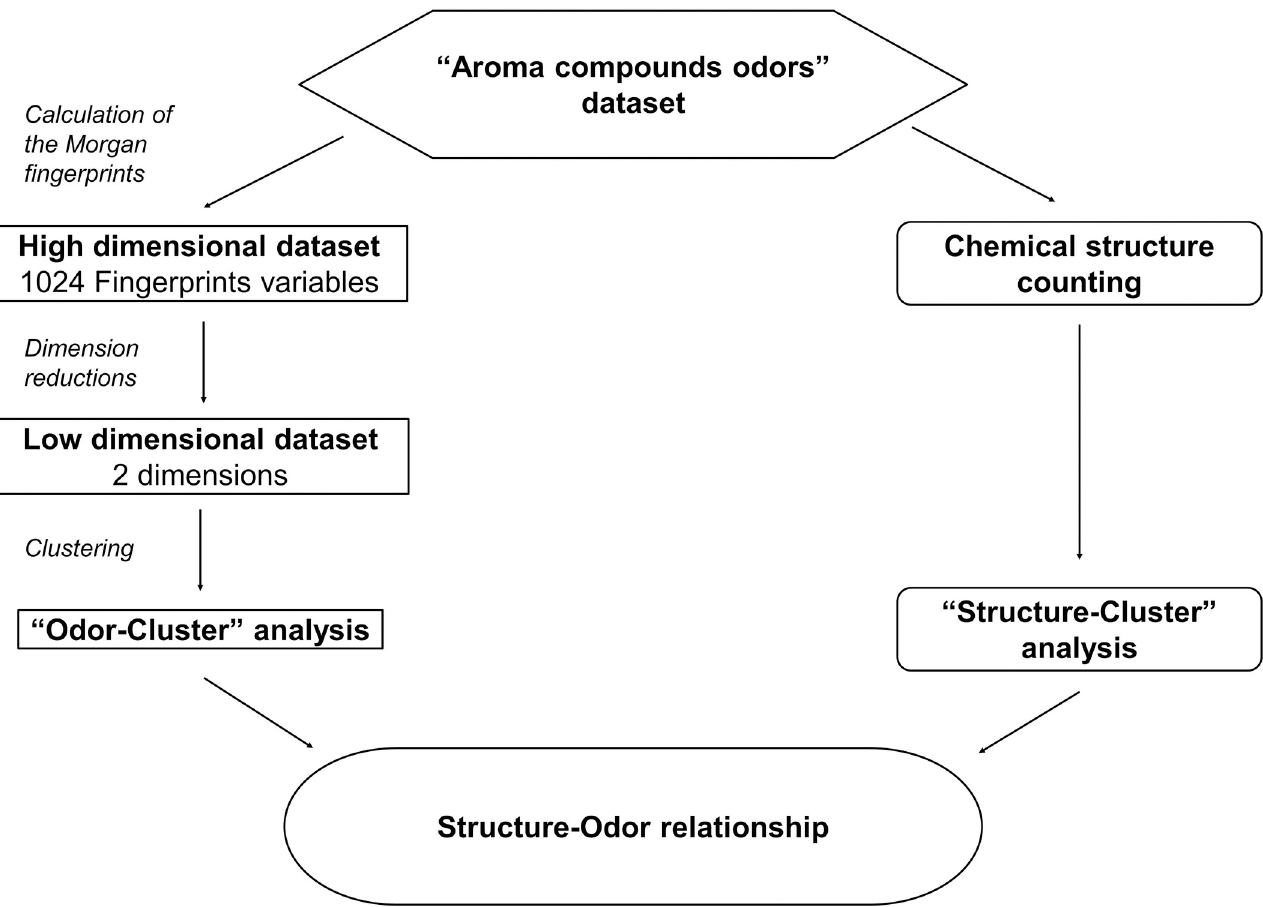
Fig 1. Representation of the workflow. On the left, reduction of the high dimensional space defined by the fingerprints and clustering; on the right, molecular substructures calculation.